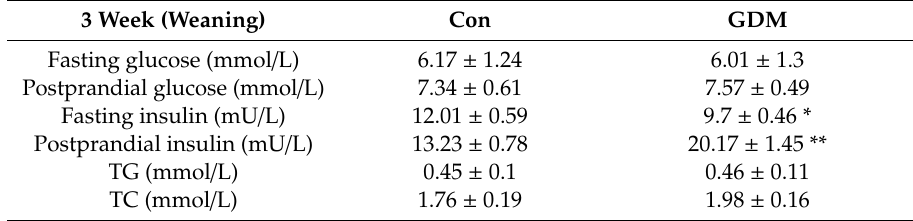
Table 1. Biochemical index of gestational diabetes mellitus (GDM) o ff spring at